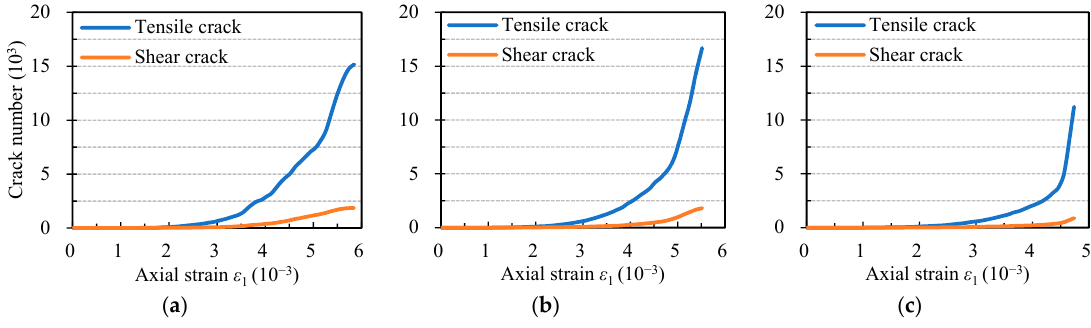
Figure 10. Intact material crack number evolution of transversely isotropic jointed rock models having dip angles of ( a ) α = 0°, ( b ) α = 15° and ( c ) α = 30°.